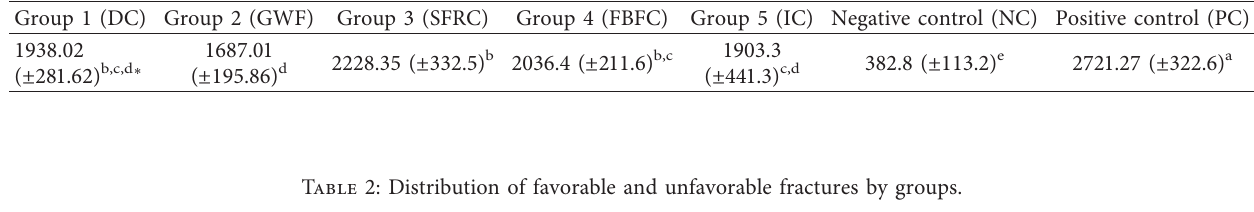
Table 1: Fracture resistance values and standard deviations.